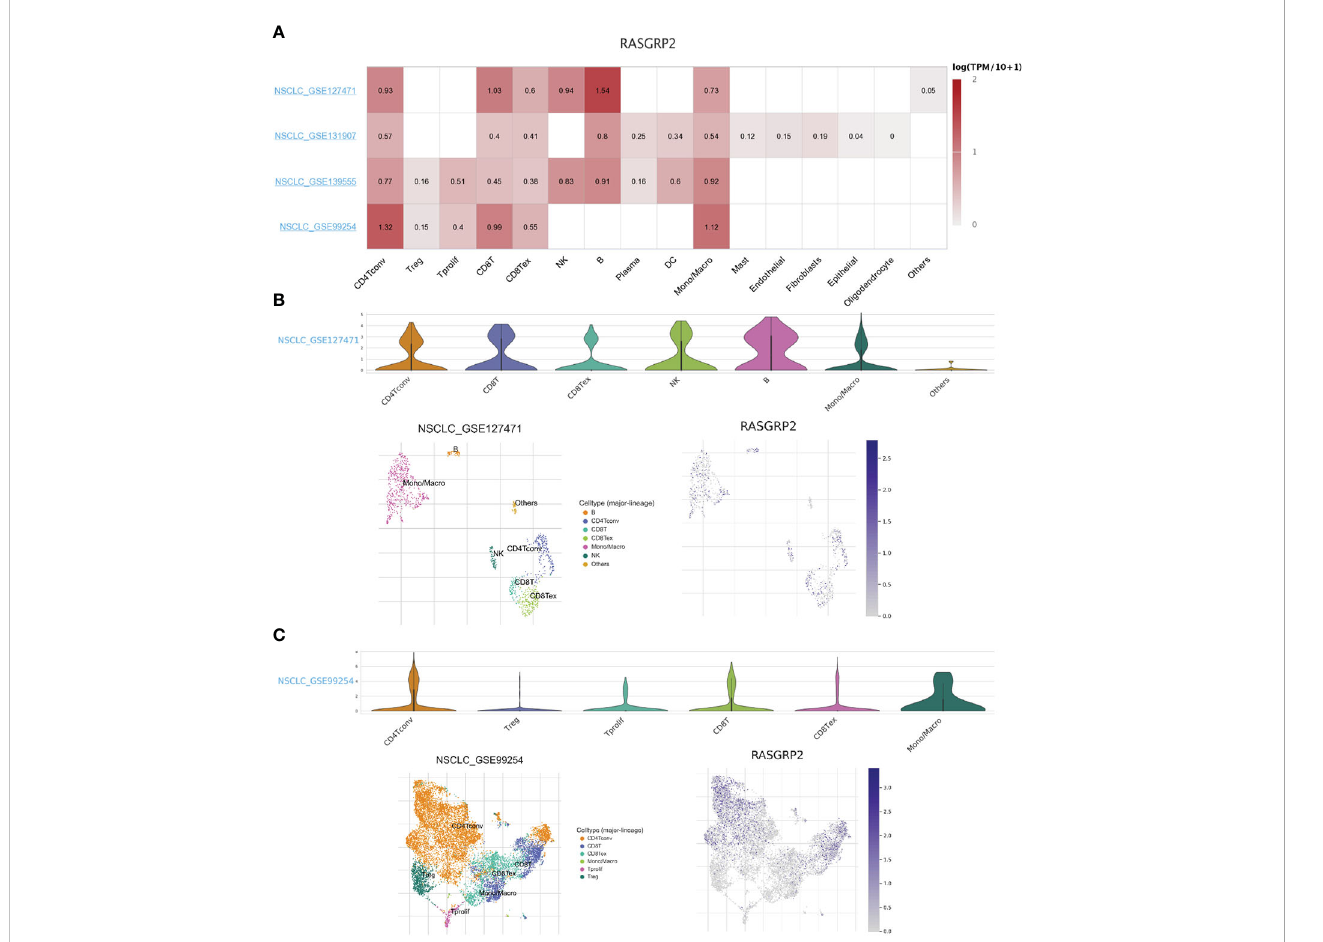
FIGURE 9 Single-cell analysis of the expression of RASGRP2 in different immune cells of LUAD. (A) Heatmap of the correlation of RASGRP2 with immune cell in fi ltration levels in 4 independent datasets based on the scRNA-seq database. (B, C) Violin plot and single-cell atlas of NMUR1 and immune cell in fi ltration in NSCLC_GSE127471 and